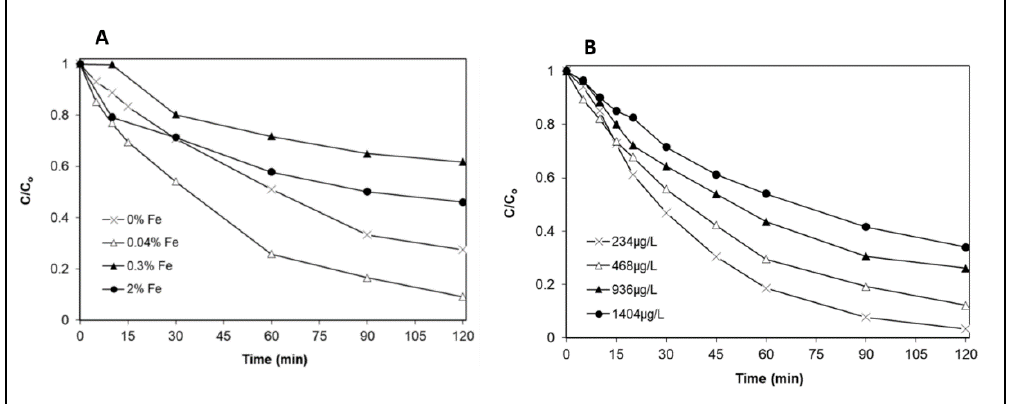
Figure 13. A proposed mechanism for the degradation of sulfamethoxazole antibiotic using (EP-TiO2-773). The degrada- tion was determined by HPLC analysis, which showed the disappearance of sulfamethoxazole peaks and the appearance of new peaks. Two pathways are mainly involved. The first pathway involves the photogeneration of hydroxyl radicals which resulted from the interaction of holes with water. The second pathway involves the electron transfer from the ex- cited organic molecule to TiO 2 conduction band. Adapted with permission from [121]. Copyright 2015 Elsevier.